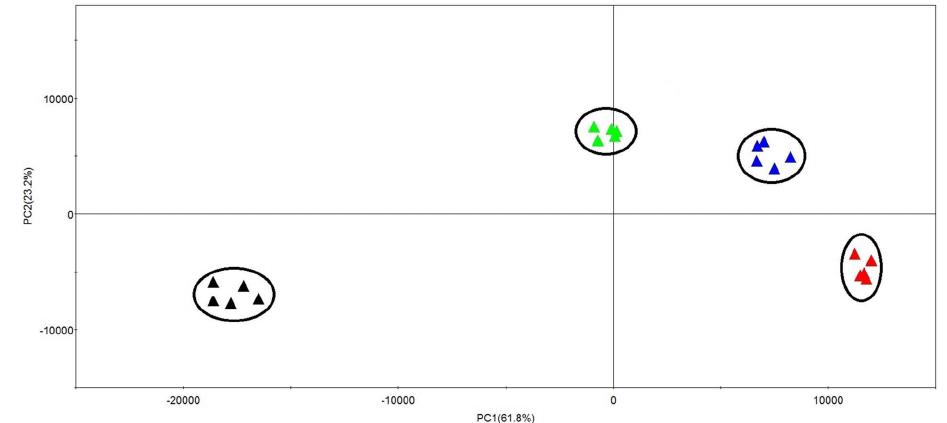
Figure 3. Principal component analysis (PCA) of metabolites from control and treatment groups (YE-